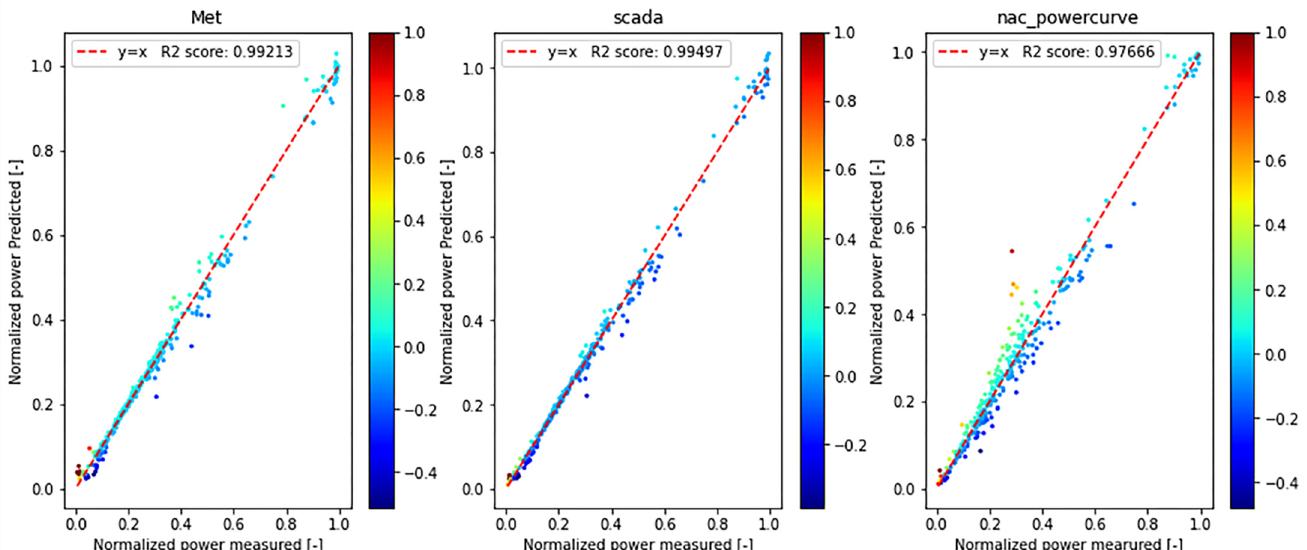
Figure 14. Comparison of predicted and actual values of different models. Table 2. Evaluation results of different models.